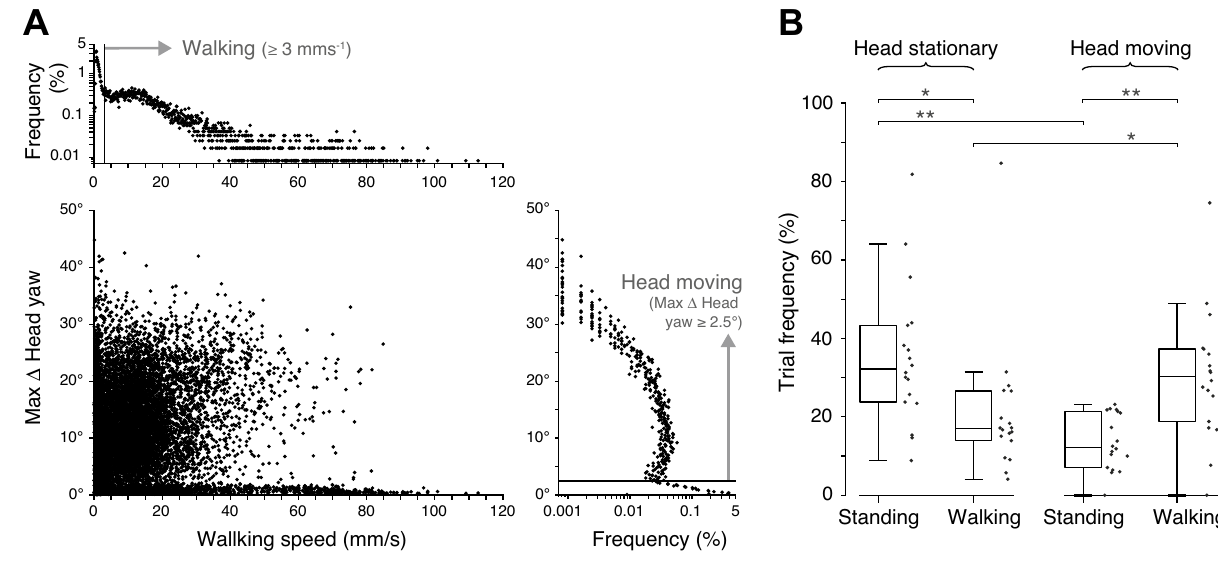
Figure 4. Flexible performance of OKN-like head movements, independent of the locomotor state. ( A ) The joint distribution of walking speed and the maximum change of the head yaw angle within an entire trial (4 s), for all flies. Flies were able to move their head or keep them still independently of whether they walked or were stationary. The largest head yaw ranges occurred for the slowest walking speeds, and fast walking flies (> 30 mm/s) either displayed large head movements or kept their heads still. Top: the distribution of walking speeds indicated a bimodal distribution of stationary and walking flies, which we classified by applying a threshold value of 3 mm/s, below which flies were defined to be stationary. Right: the distribution of maximum changes in head yaw angle also indicated a bimodal distribution of flies with heads still or heads moved which we classified by applying a threshold value of 2.5°/s, below which flies were defined to have stationary heads. ( B ) Percentage frequencies of trials in which, from left to right, the flies were: standing with head stationary, 35 ± 18%; walking with head stationary, 21 ± 18%; standing with head moving, 14 ± 7%; walking with head moving, 30 ± 17%; all values, mean ± std, N = 18. Boxplots indicate the median and quartile ranges, and the whiskers indicate the range of data points that are not outliers. Asterisks indicate statistical significance of comparisons of rates of walking versus being stationary for flies with stationary heads, and moving heads (Wilcoxon signed rank tests, with Holm-Bonferroni correction for 4 comparisons; N = 18; ** p < 0.01, *** p < N = 18; Fig. 4B). However, we also observed head movements in standing flies, and stationary heads in walking flies (Fig. 4B). To quantify the effect of visual motion on yaw head rotations in trials where the fly moved her head, we cal- culated an optokinetic index (OKI). The OKI is defined as the yaw angle accumulated during fast saccadic head turns minus the accumulated angle due to slow turns during the period of visual stimulation, scaled to a unit time of 1 s (see “Methods”). Thus, if in one second a fly saccades 10° against the yaw grating, and then compensates for the motion of the grating with slow turns for 10°, the optokinetic index is 20°/s. The range of observed head movements was limited to a maximum of ~ 40° (Fig. 4A, Right). The largest head yaw ranges (max Δ head yaw,